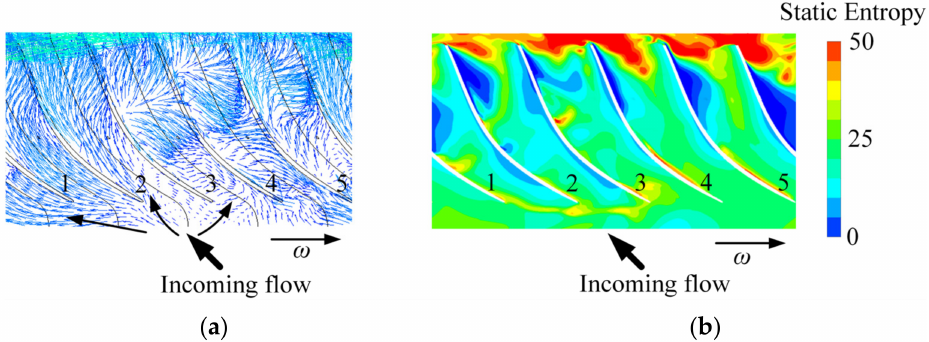
Figure 10. Contours of the instantaneous relative velocity vector and corresponding entropy increase in the impeller passages (IGV30, 97% span, ϕ = 0.0833): ( a ) relative velocity vector; ( b ) static entropy.